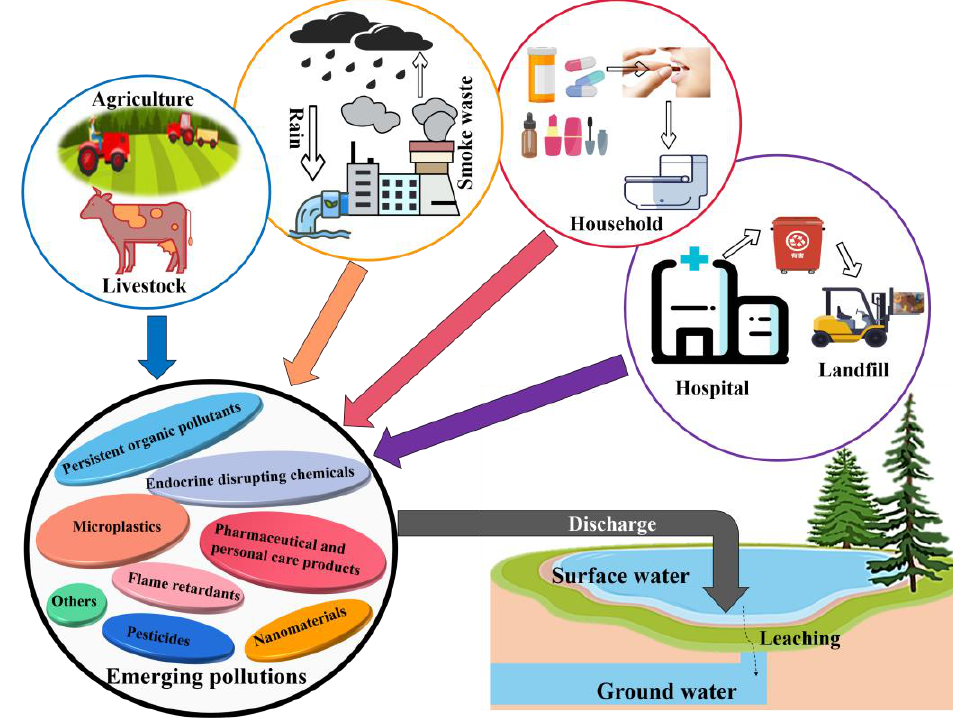
Figure 1. Resource of emerging pollutants and routes to the aquatic